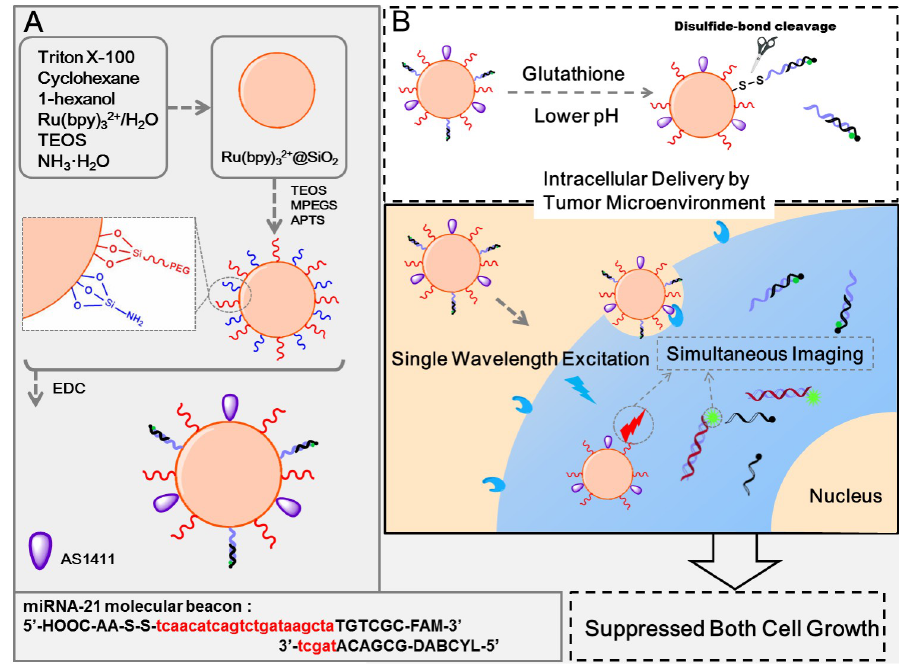
Figure 14. Schematic of the synthesis of FS-AS/MB and strategy of cancer-targeting theranostics using FS-AS/MB. Reprinted with permission from [74]. Copyright 2014 American Chemical